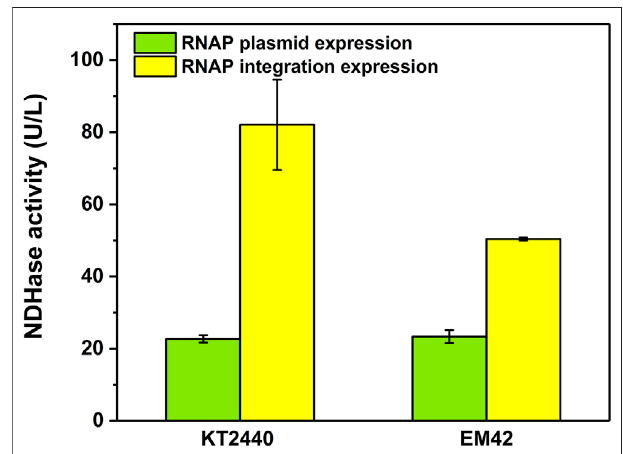
FIGURE 6 | The RFI of the T7 and MmP1 expression system compared with the other inducible expression systems. The number to the right of each column represents the optimized inducer concentration.